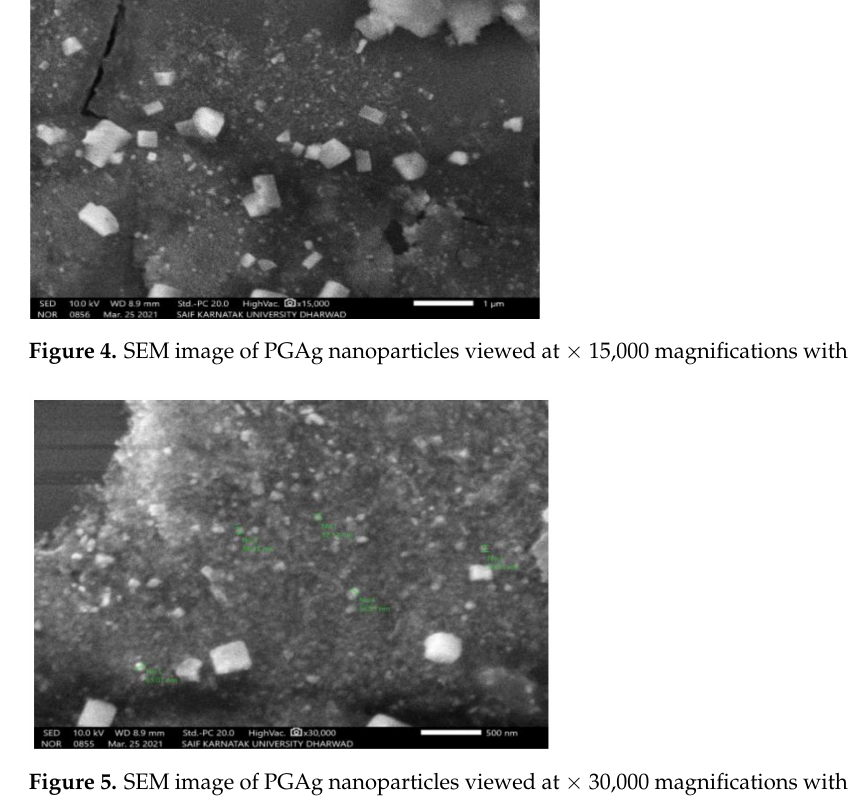
Figure 5. SEM image of PGAg nanoparticles viewed at × 30,000 magnifications with an 8.8 mm scale.